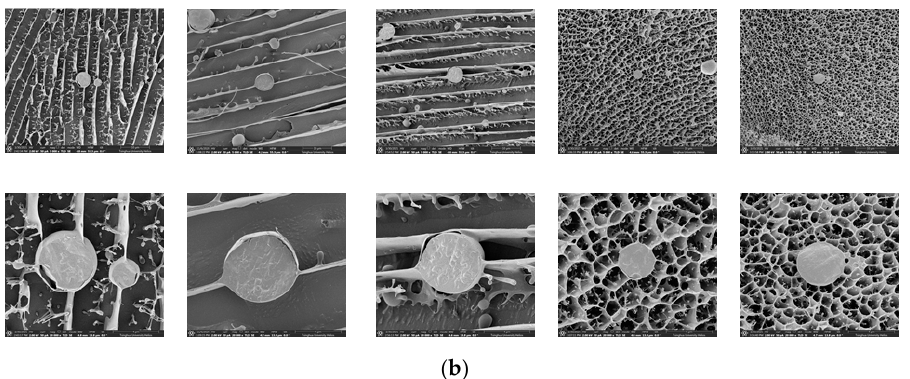
Figure 6. The CLSM microstructure ( a ) and Cryo-SEM imaging; ( b ) of S/O/W emulsions at different concentrations of NaCas and 5% proportions of S/O phase. (( a ): A, O phase was stained with Nile red, excitation at 488 nm; B, W phase was stained with Nile blue, excitation at 635 nm (ii); C, combined image). Scale bar: 20 um; ( b ): A, 5000×; B, 20,000× (1–5: 2, 4, 6, 8, and 10 wt% NaCas, respectively)).